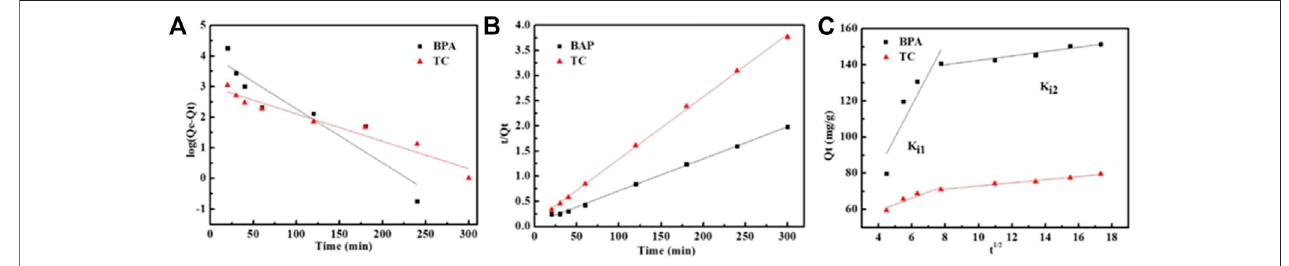
FIGURE 6 | Fit of kinetic data to (A) the pseudo- fi rst-order model, (B) the pseudo-second-order model, and (C) the intraparticle diffusion model on BPA and TC.